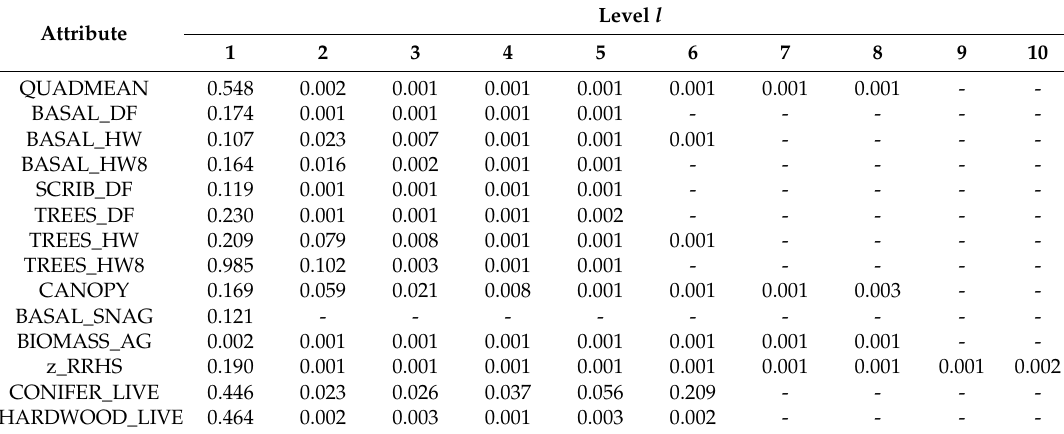
Table 4. p -Values for attributes at level l for den NCs compared to kernel NCs excluding den